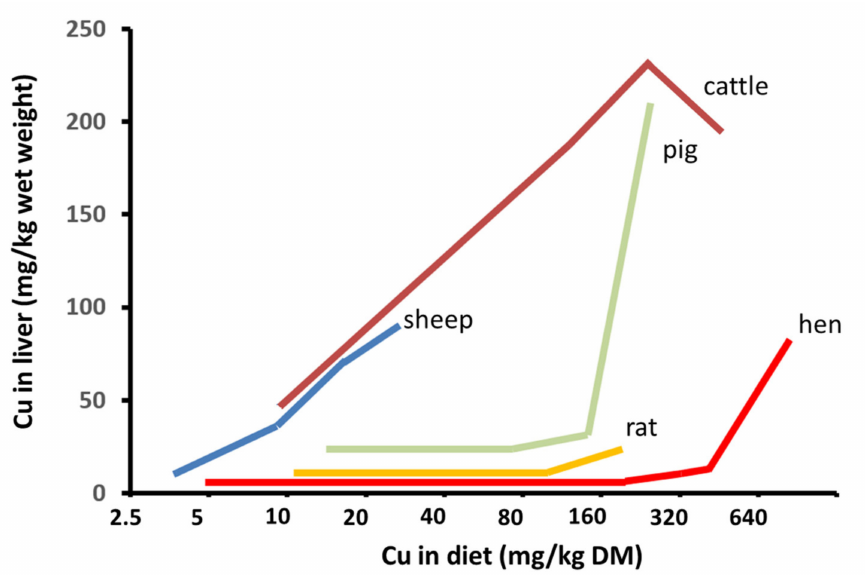
Figure 3. Species di ff erences in responses in liver copper deposition to increased dietary copper